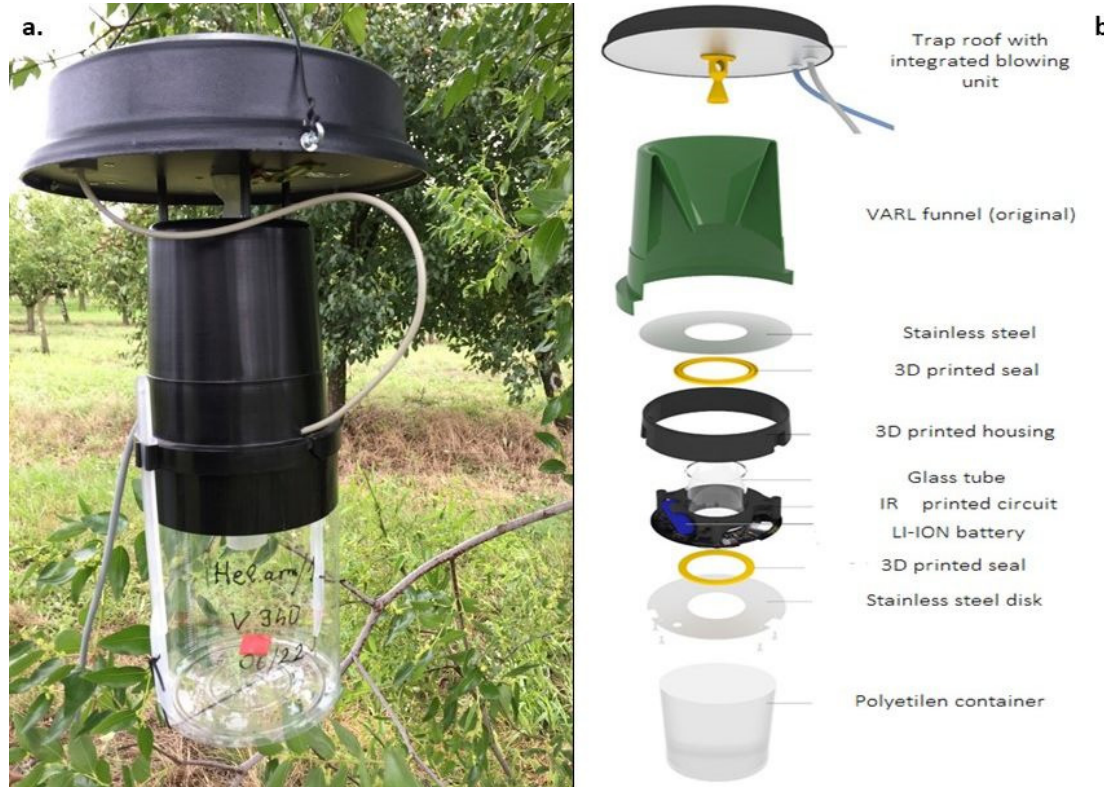
Figure 1. ZooLog VARL probe prototype in the field ( a ) and its 3D schematic diagram ( b ). The probe was built to detect flying insects, mostly pest moths and other lepidopteran pests. The probe was baited with a pheromone lure of the target insect; insects dropping through the funnels into the catch container could not escape. An infrared sensor-ring detects the individuals, and a blow-off system directs the flying insects toward the catch container. For further details, see Supplement